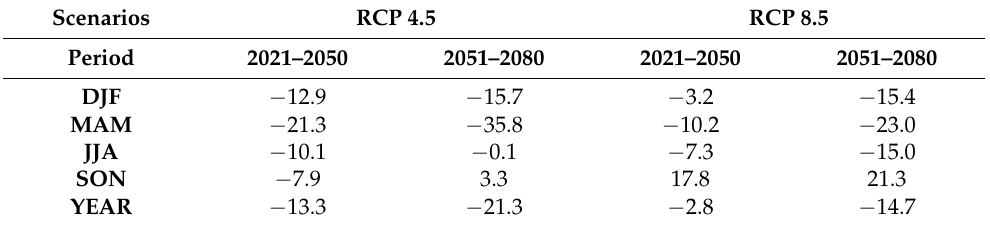
Table 5. Variation (%) in the generation potential between the projections and the reference period